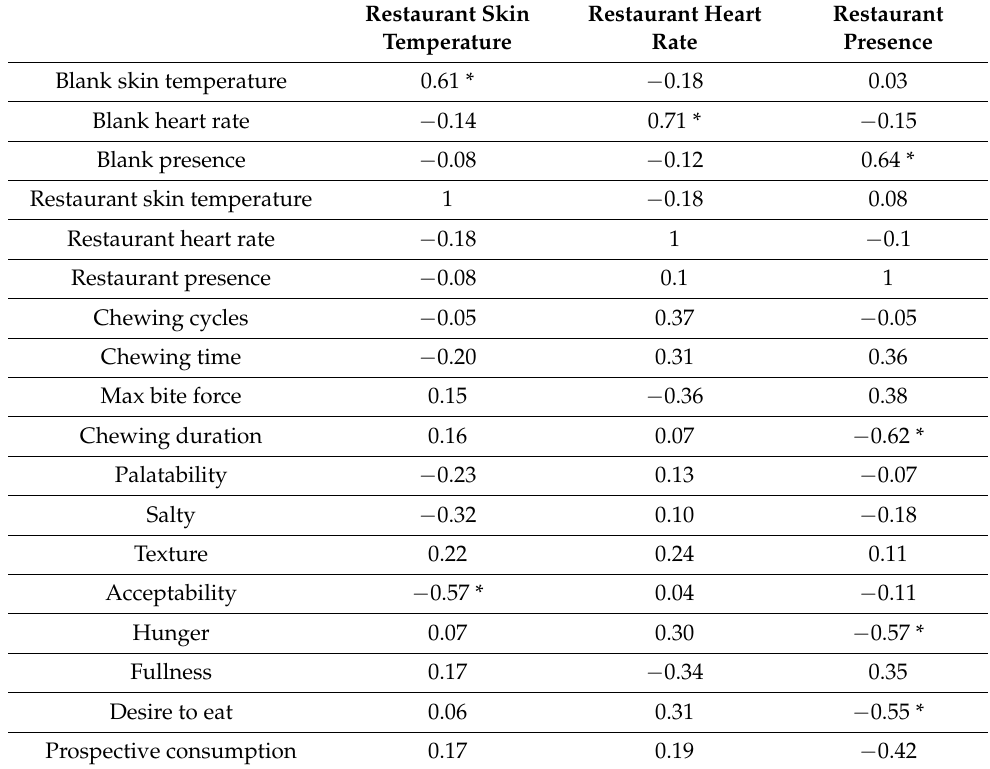
Table 4. Correlation coefficients between markers of presence and masticatory parameters in the restaurant scene. * p <